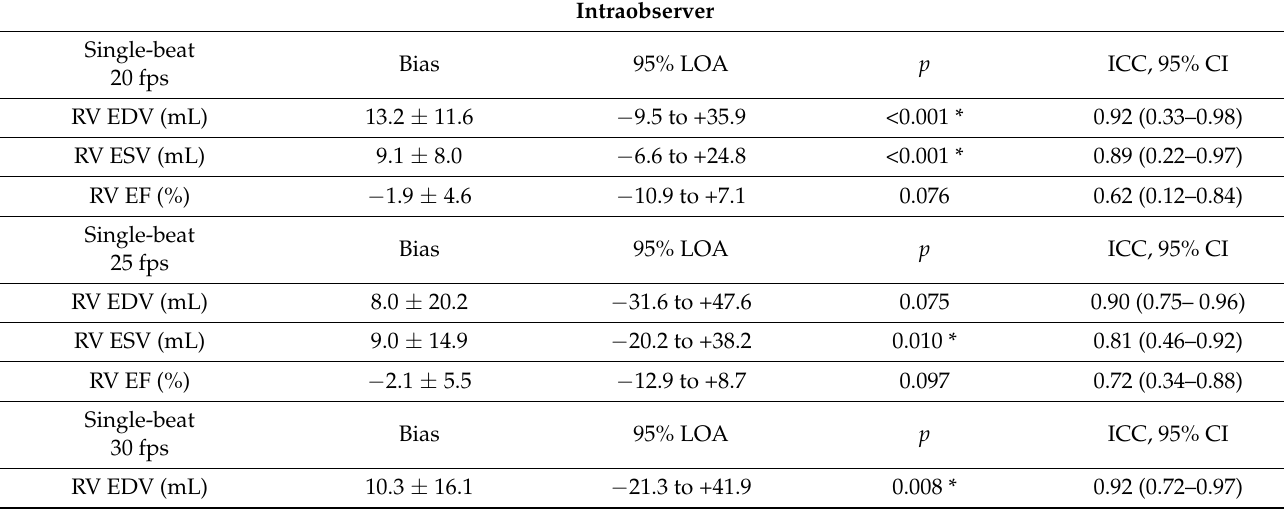
Table A1. Results of the 3DE reproducibility study in healthy volunteers (group 1). Intra- and interobserver analysis is evaluated using Bland–Altman analysis (Bias ± SD and 95% upper LOA to 95% lower LOA), paired Student t -test ( p ) and Intraclass correlation coefficient